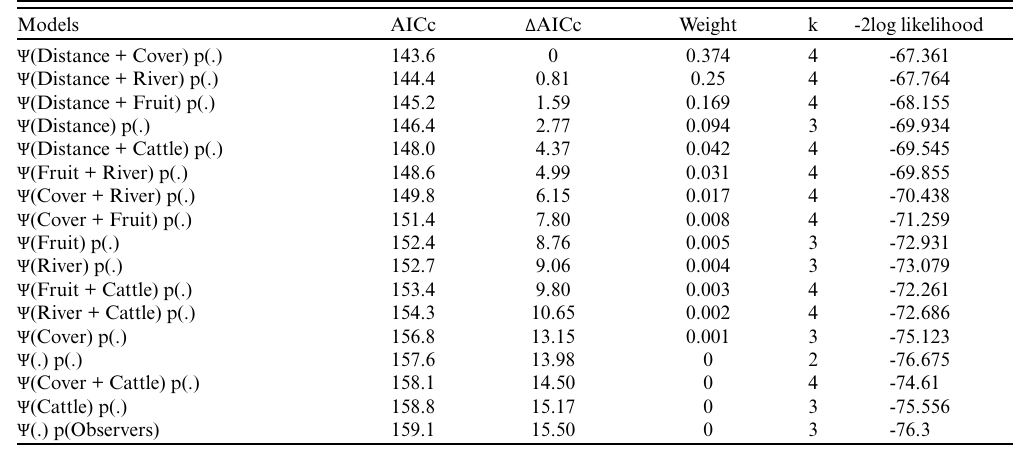
Table 2 . Top occupancy models for Bare-faced Curassow of the Humid Chaco, northern Argentina. Information presented for each model: Quasi-Akaike’s information criterion (AICc), change in AICc ( Δ AICc), Akaike weights, number of parameters (k), and deviance (-2log likelihood). Models AICc Δ AICc Weight k